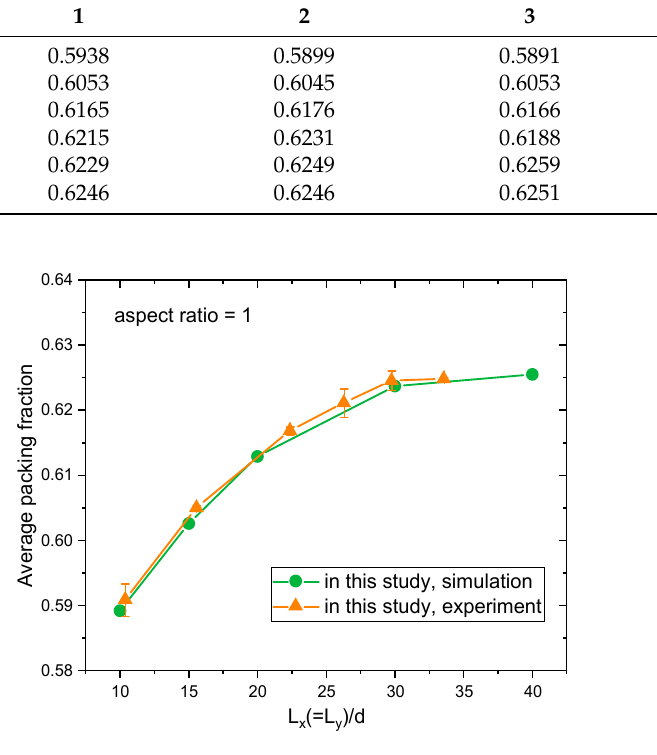
Figure 2. Comparison of the γ avg of the pebble beds in square tubes.